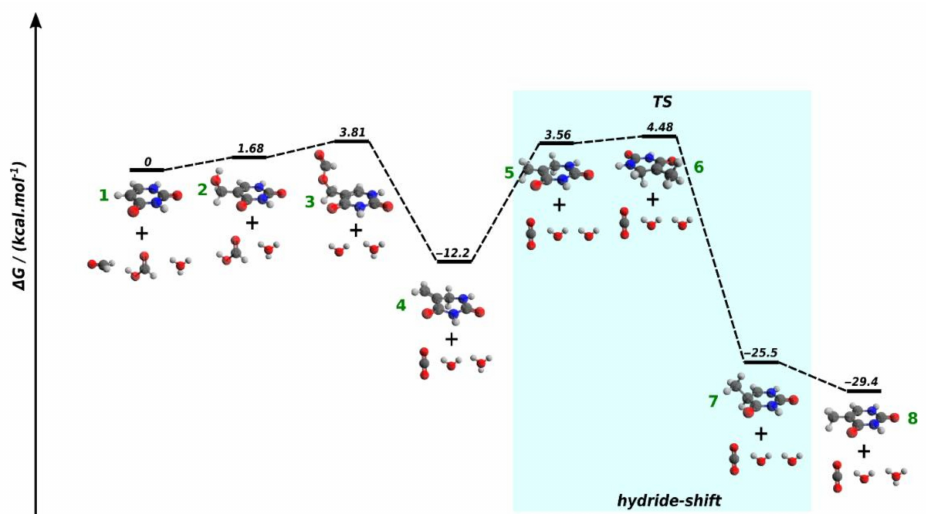
Figure 3. Free energy ( ∆ G) profile for the conversion of uracil to thymine based on B3LYP/6-31G* calculations. Color coding used in the models: C—dark grey, H—light grey, O—oxygen, N—nitrogen. For Cartesian coordinates of the optimized geometries of compounds 1 - 8 , see the Supplementary